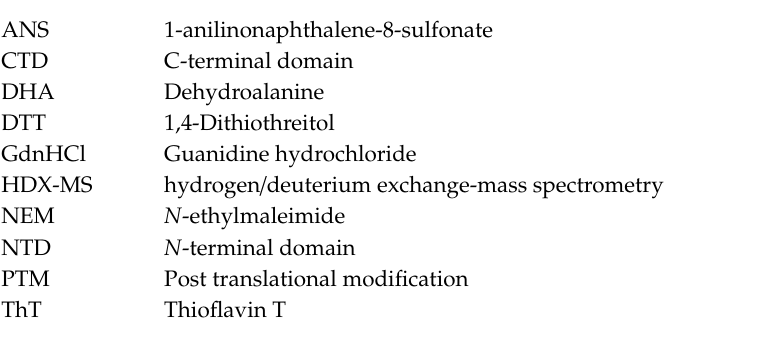
Table S1. Comparison of di ff erential deuterium exchange rates of identified WT and mutant of β B2-crystallin peptides in HDX-MS experiment.; Table S2. Identified PSMs with a minimum peptide length of 8 were identified at FDR 1%; Table S3. Identified Mutations.; Table S4. The list of possible mutations from nuclear cataract human lens samples. (a) Numbers of mutations observed in each crystallin. A total of 112 mutations were observed in our analyses. (b) Numbers of mutations observed in each